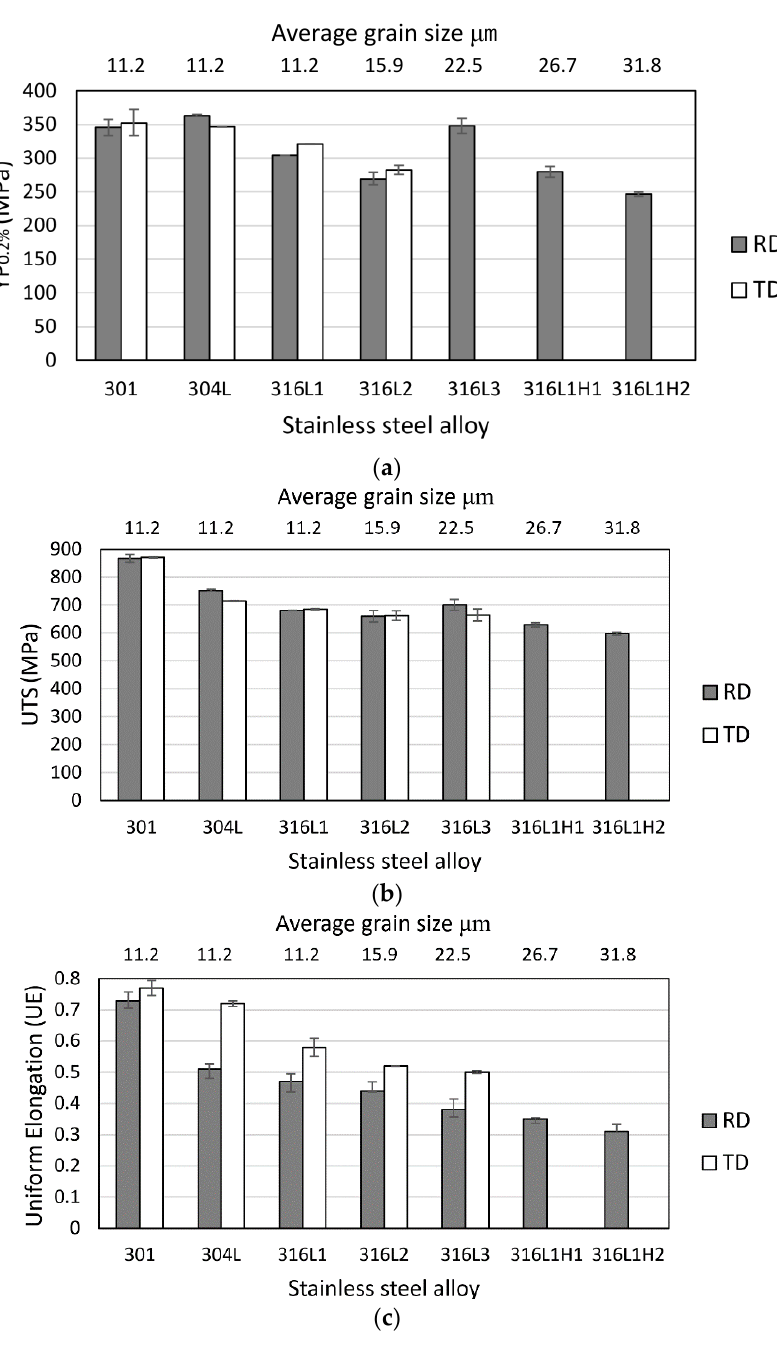
Figure 10. Tensile parameters determined with samples oriented in RD and TD with the averaged grain size measured for each particular alloy shown. ( a ) Yield Strength (YP 0.2 ); ( b ) Ultimate Tensile Strength (UTS); ( c ) Uniform Elongation (UE).